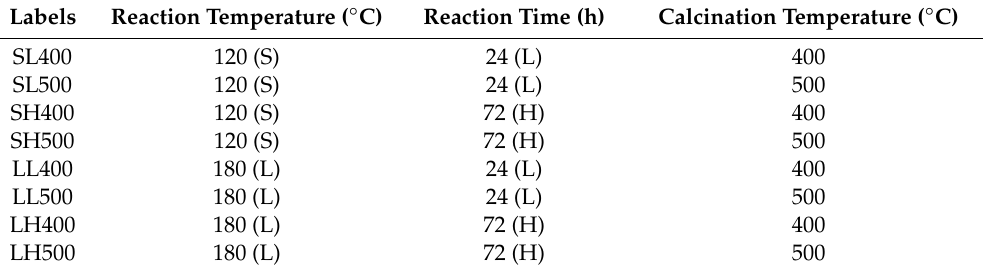
Table 1. Experimental runs of the 2 3 factorial design.